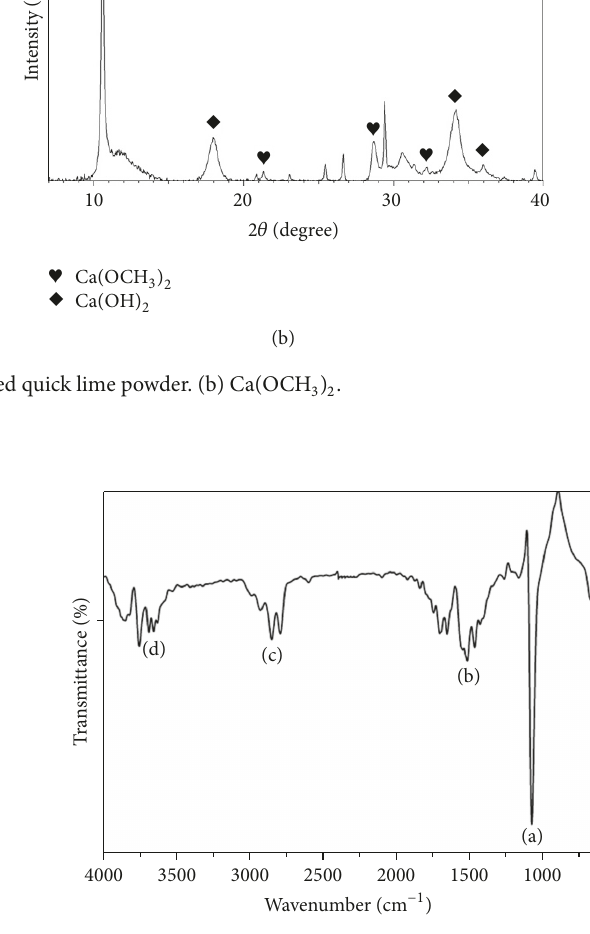
Figure 3: ATR-FTIR spectrum of Ca(OCH 3 ) 2